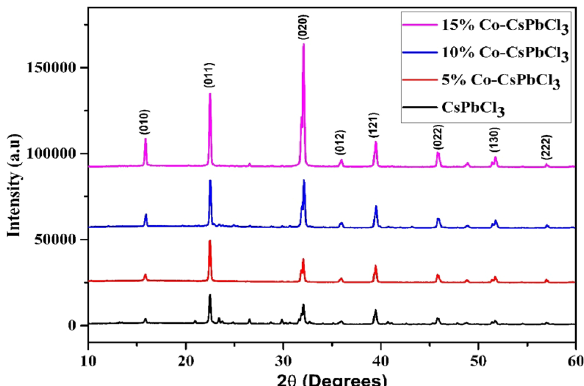
Figure 2. XRD graph of the Pristine and Co doped CsPbCl 3 nanostructures.